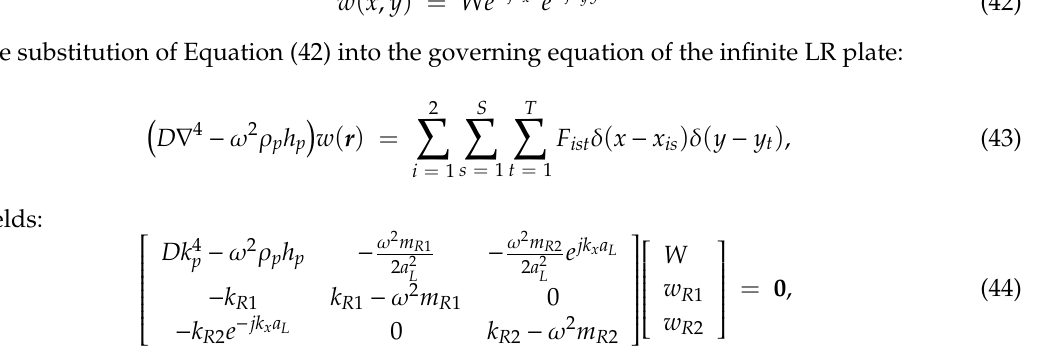
Figure 10. The radiation efficiencies of the mass-loaded (ML) plate, the locally resonant (LR) plate with undamped resonators ( η R 1,2 = 0), and the LR plate with damped resonators ( η R 1,2 = 0.05 ), with ( a ) fully free boundary conditions, ( b ) fully simply supported boundary conditions, and ( c ) fully clamped boundary conditions.